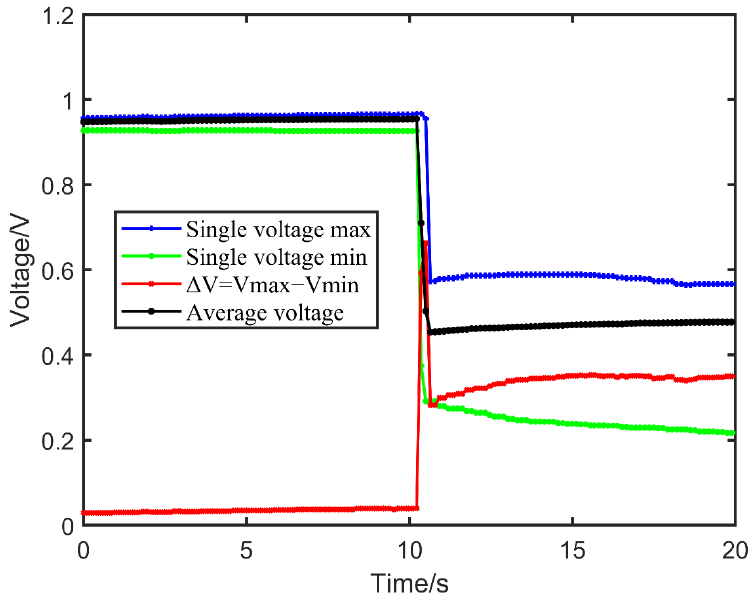
Figure 6. Evolution of maximum, minimum, average single cell voltage, and single cell voltage range ( V max , V min , V average , and Δ(cid:1848) (cid:2913)(cid:2915)(cid:2922)(cid:2922) ) with the stack temperature of − 8 °C. ( V max , V min , V average , and ∆ V cell ) with the stack temperature of − 8 ◦